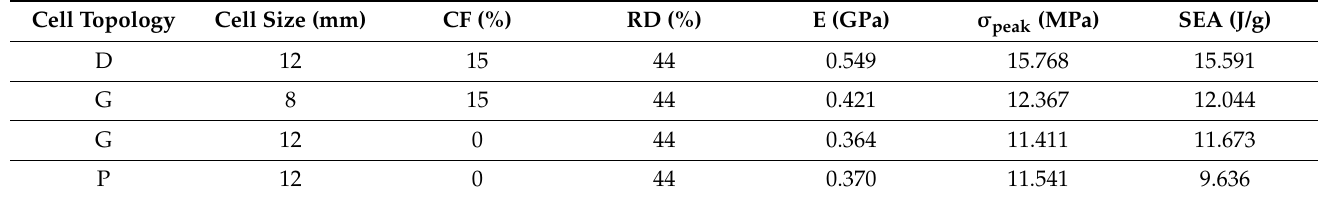
Table 15. Validation experiments for multi-objective